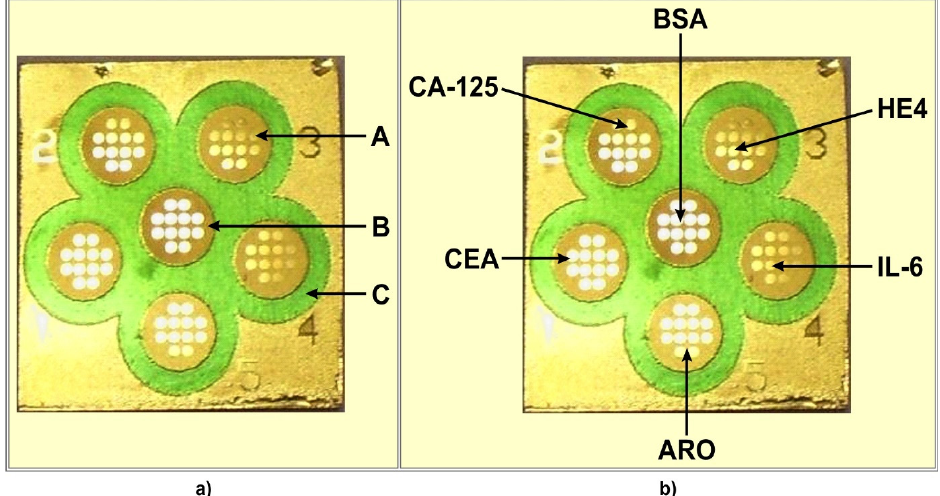
Figure 1. Chip ( a ) and multiple biosensor ( b ) architecture. (A) free gold surface, (B) and (C) different hydrophobic paints. (CA125), (CEA), (ARO), (IL-6), (HE4) locations of particular biosensors on the multiple biosensor. (BSA) location of BSA.